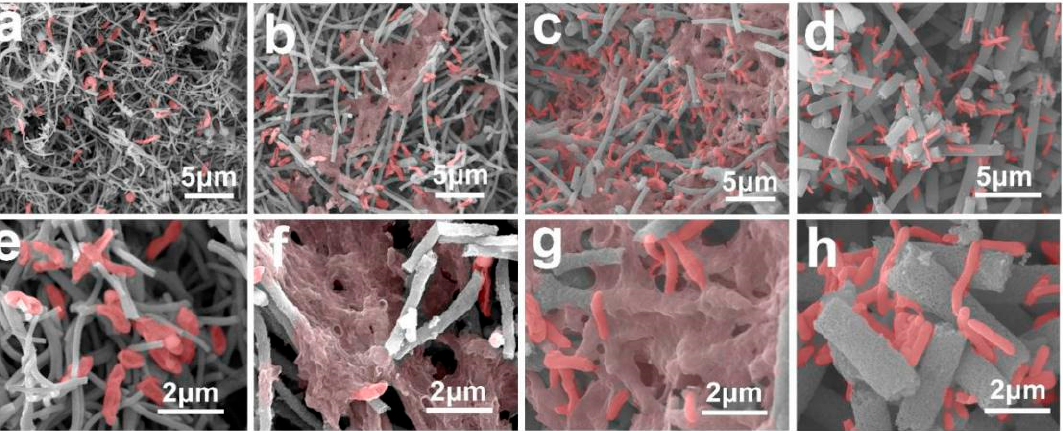
Figure 6. FESEM images of the bacterial cells adhered to the electrode surface after 14 days MFCs operation. ( a , e ) CPAN, ( b , f ) NPCF-1, ( c , g ) NPCF-2 and ( d , h ) NPCF-3.